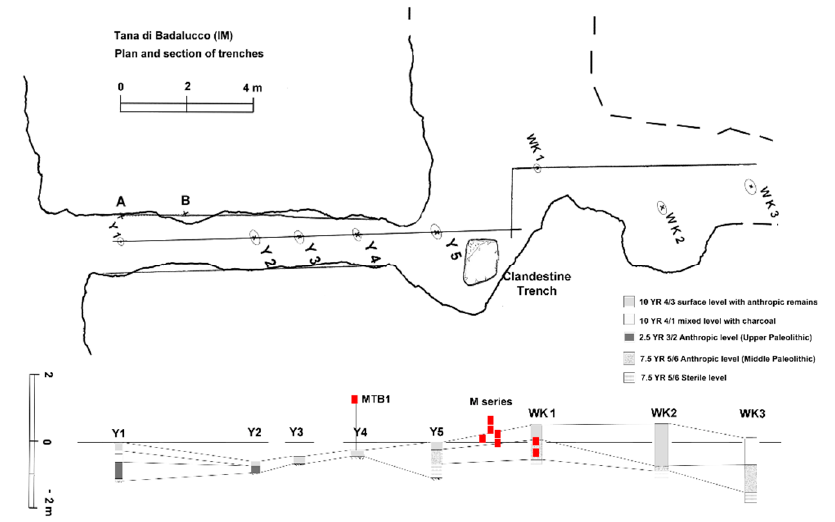
Figure 1. Map of Tana di Badalucco cave.